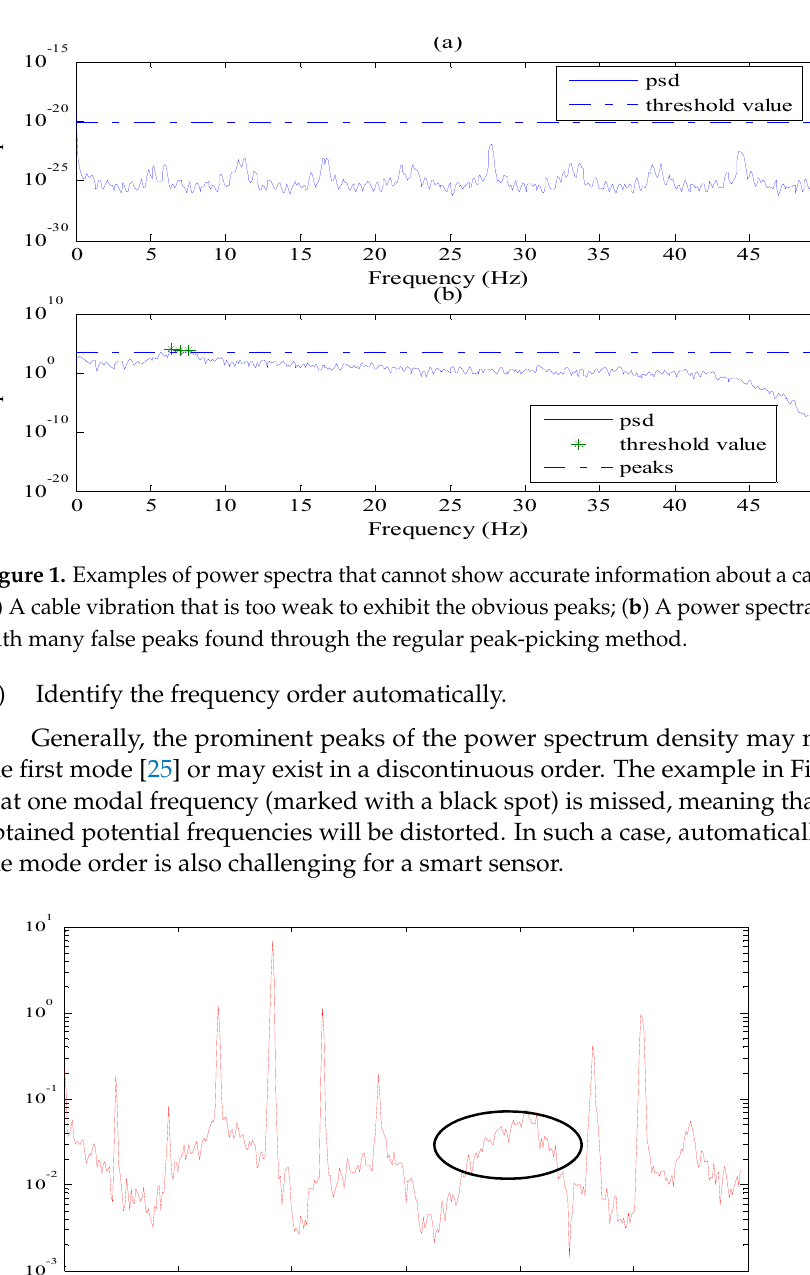
Figure 1. Examples of power spectra that cannot show accurate information about a cable’s fre- quency. ( a ) A cable vibration that is too weak to exhibit the obvious peaks; ( b ) A power spectral density (PSD) with many false peaks found through the regular peak-picking method.